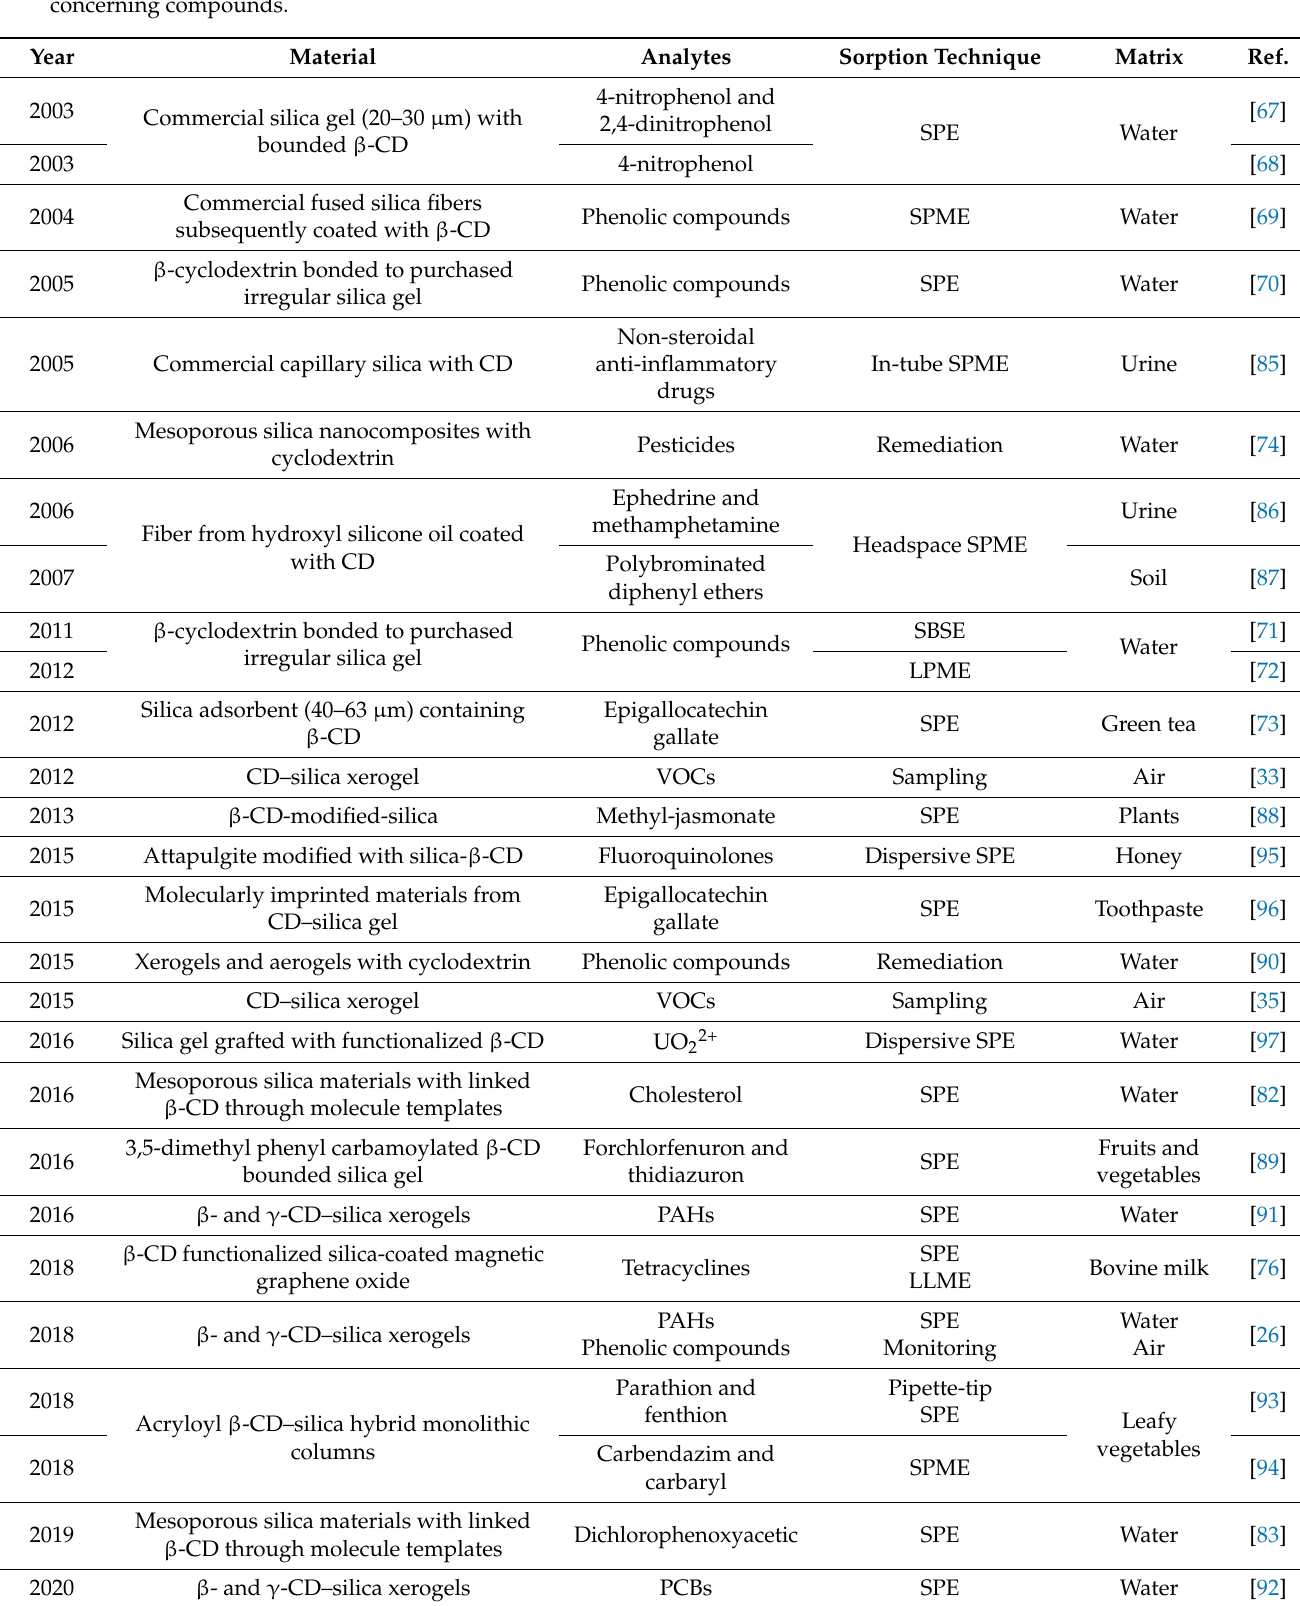
Table 1. An overview of the reported studies on the use of cyclodextrin–silica materials for the adsorption of environmentally concerning